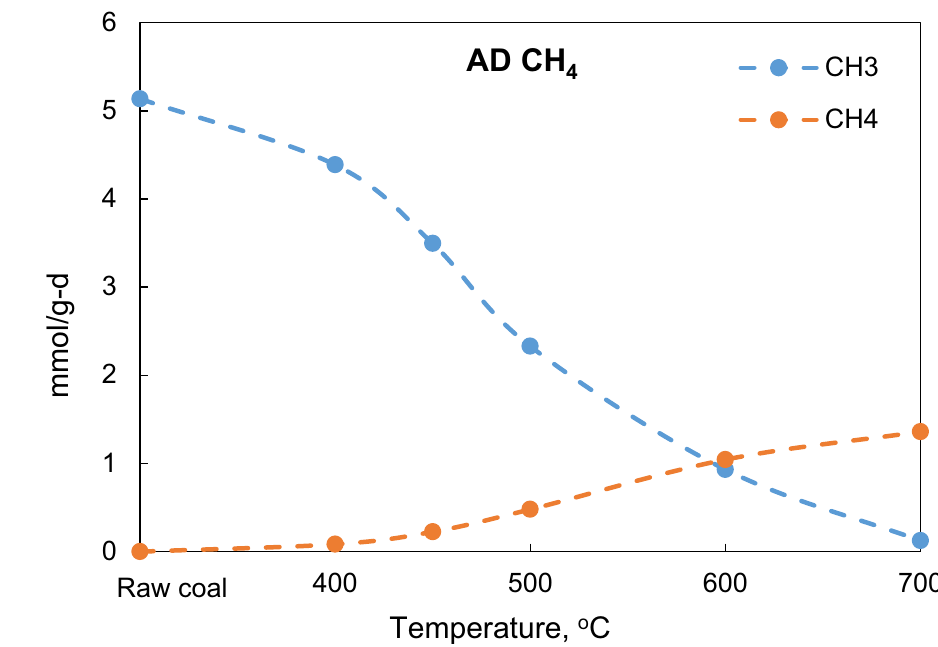
Fig. 7 Integration of CH 4 as a function of temperature and the trends of its relevant functional groups of -CH 3 of coal AD